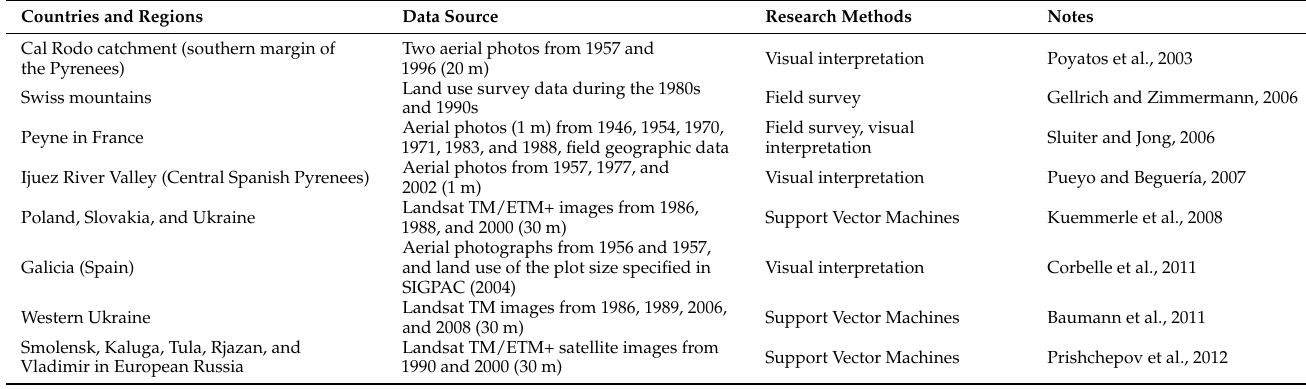
Table 5. Evolution of methods for the extraction of abandoned